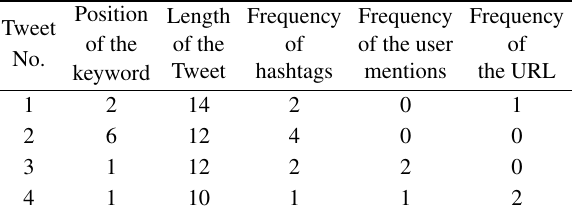
Table 3 Parameter detail of the classifiers.